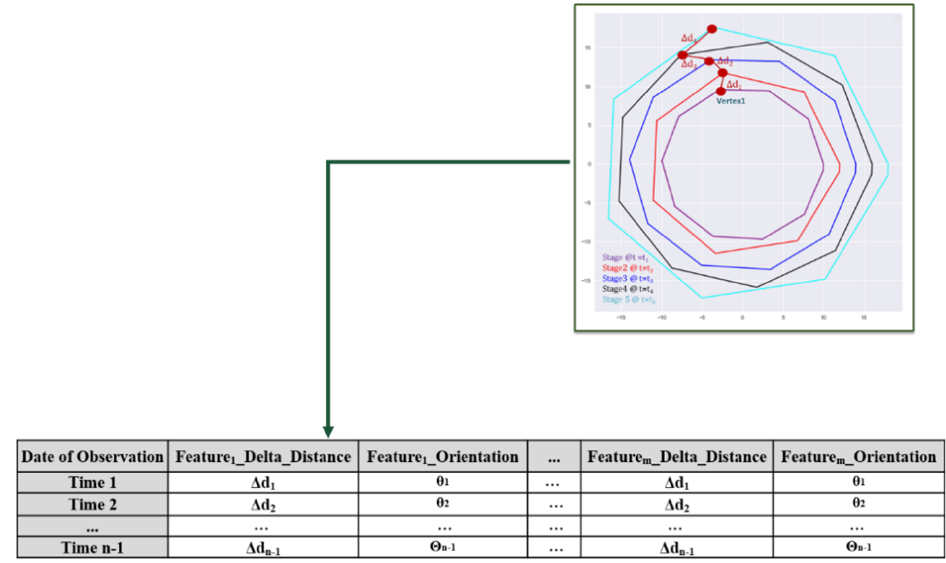
Figure 5. Dataset representing the extracted vertices for a time-series evolution of an arbitrary polygonal defect.